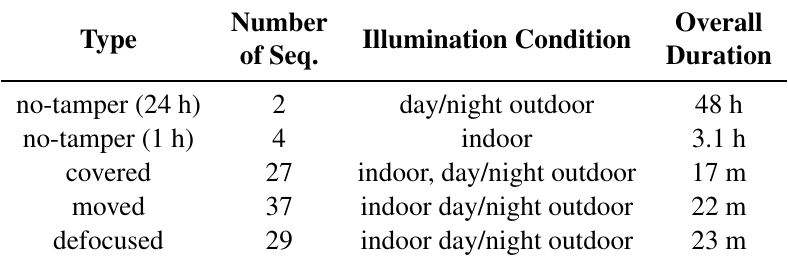
Table 2. Video sequences for performance